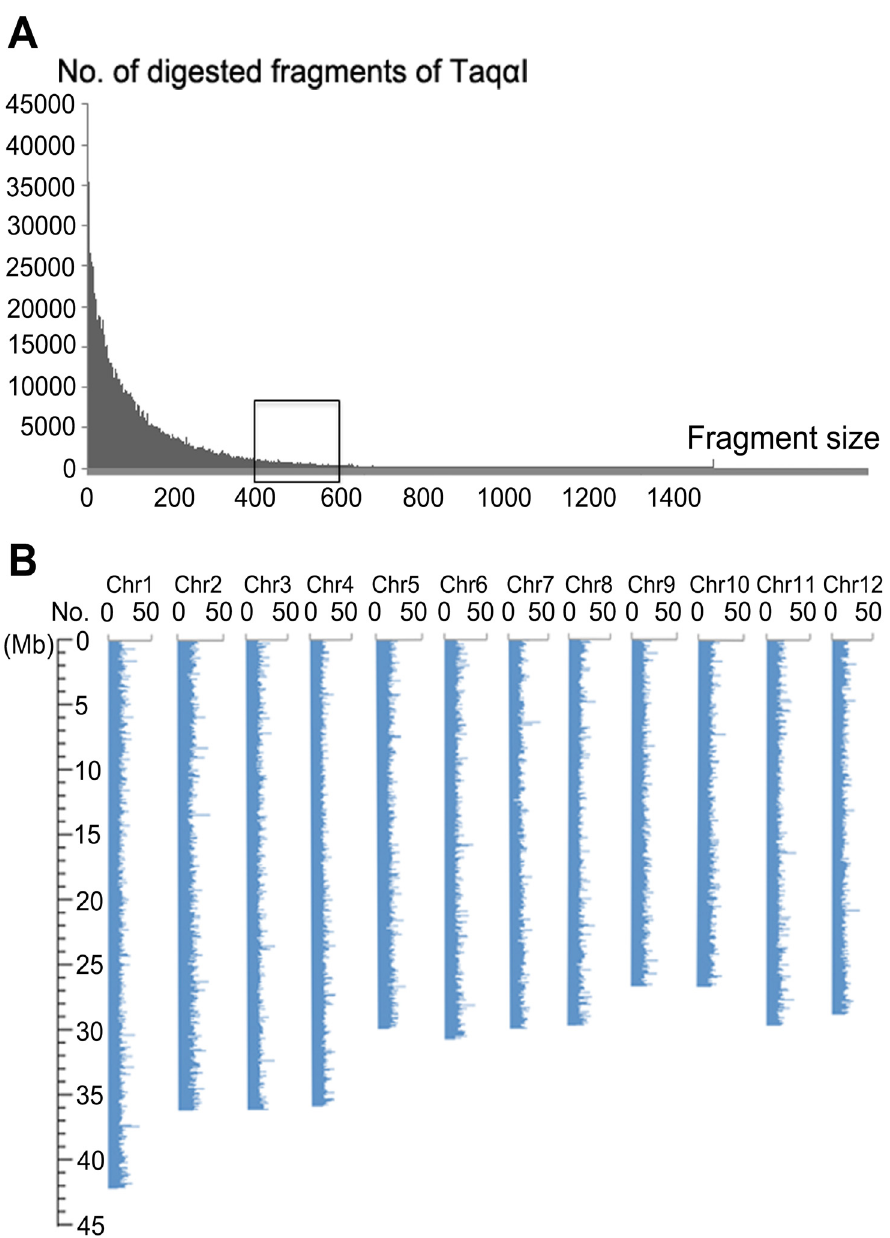
Fig 2. In-silico prediction of digested fragments of the rice genome. (A) In-silico digestion with Taq α I of rice genome, showing 130,940 digested fragments between 400 – 600 bp in size. The X axis indicates the length of digested fragments; The Y axis indicates the number of digested fragments. (B) Density distribution of Taq α I recognition sites in the rice genome. The X axis indicates twelve chromosomes; The Y axis indicates the number of restriction enzyme sites. The result showed the restriction digestion sites for Taq α I were evenly distributed in the rice genome.